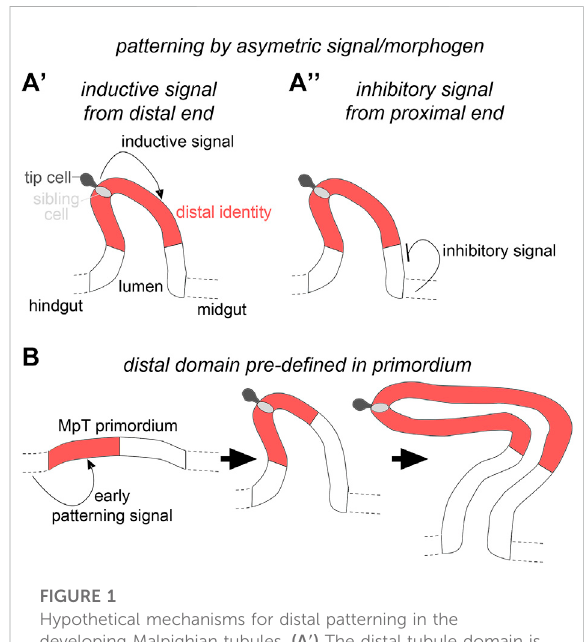
FIGURE 1 Hypothetical mechanisms for distal patterning in the developing Malpighian tubules. (A 9 ) The distal tubule domain is speci fi ed by an inductive signal emanating from the distal tubule end,or (A 99 ) aninhibitorysignalfromtheproximaltubuleend. (B) The distal tubule domain is pre-patterned in the